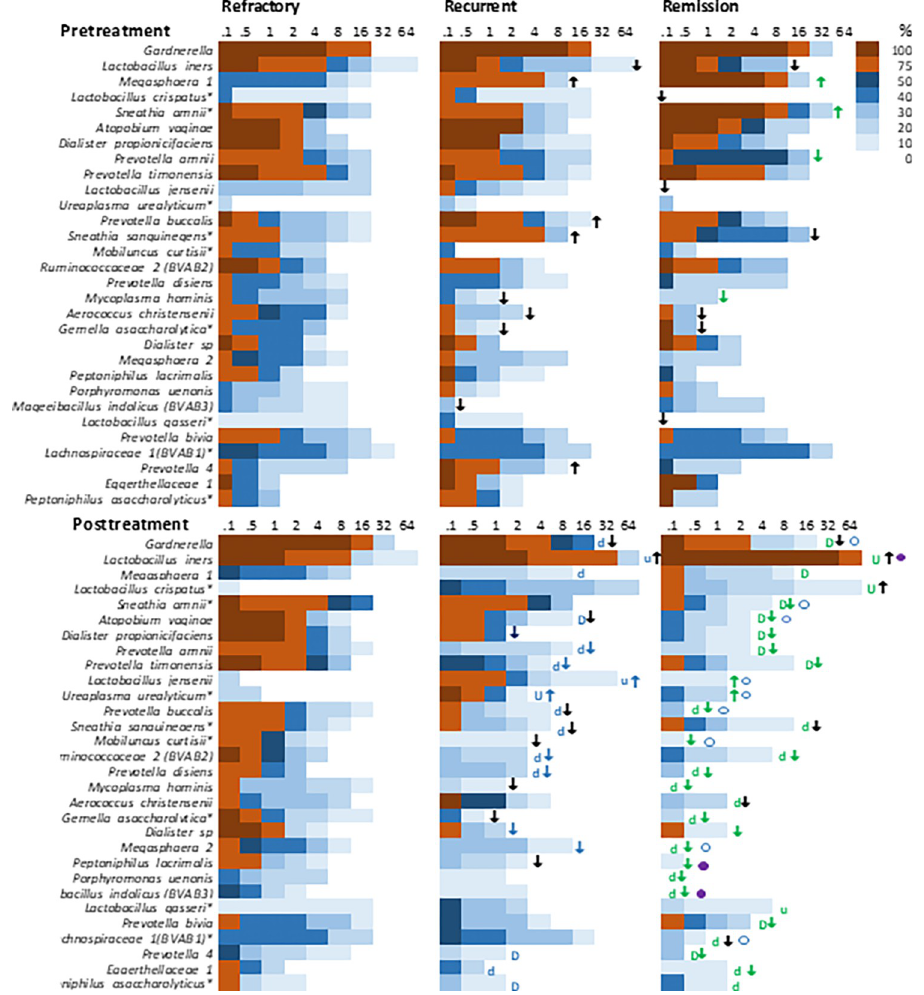
Fig 6. Heat maps of abundance and prevalence of core microbiota of refractory, recurrent and remission patient samples pre- and posttreatment. The color scale classifies upper limits of % prevalence categories. Percent abundance is binned as indicated on the x-axis. Outcome group comparisons (horizontal): " or # indicates a large visual up or down change in either abundance or prevalence of the species relative to that seen in the refractory patient, color coded if the difference was significant (p value < 0.05 by abundance using the Kruskal Wallis test, Bonferroni corrected, or by prevalence using ChiSq or Fisher’s exact tests, SPSS). The open circle indicates a large visual change in abundance or prevalence of a remission sample species relative to recurrent samples; a closed circle indicates that the difference was significant (p < 0.05, by abundance using Kruskal Wallis test, Bonferroni corrected, or by prevalence using ChiSq or Fisher’s exact tests, SPSS). Pre- versus posttreatment comparisons of change in relative abundance (top versus bottom panel): U and D denote large up or down changes, capitalization indicates the difference was significant (p < 0.05 by abundance assessed by Wilconox rank match pairs tests or by prevalence assessed by paired samples proportions tests with Wald’s test of significance (SPSS).